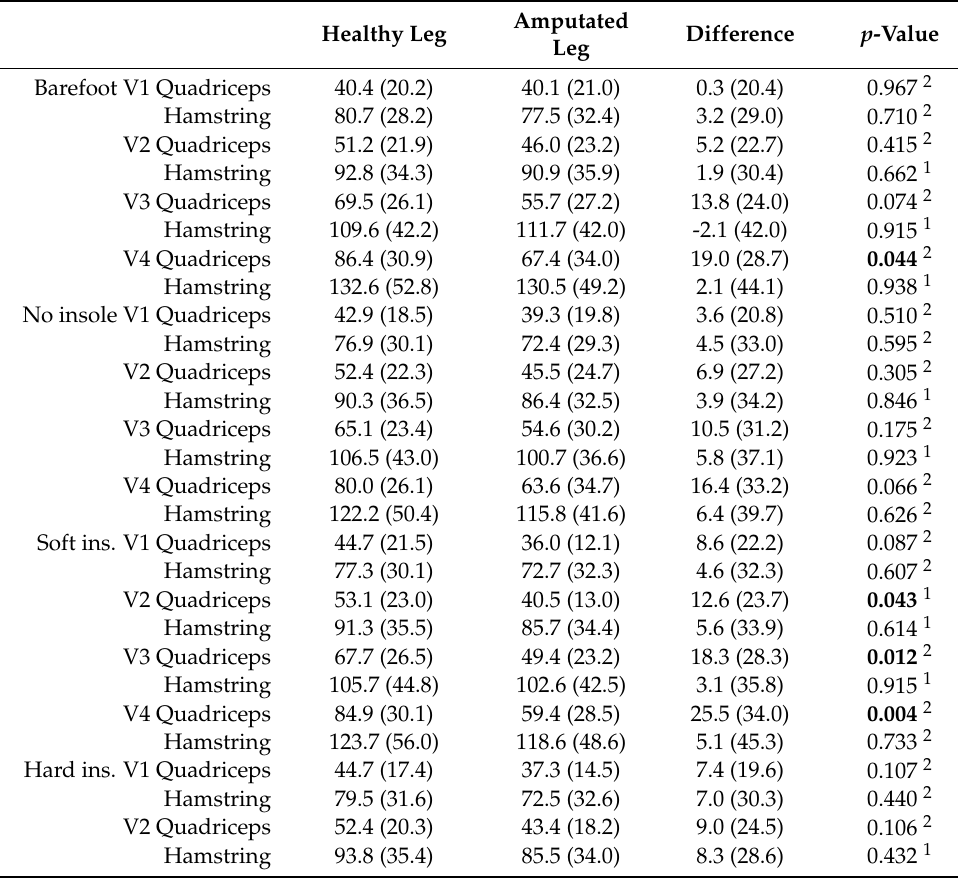
Table A1. EMG according to situation and leg in the amputee